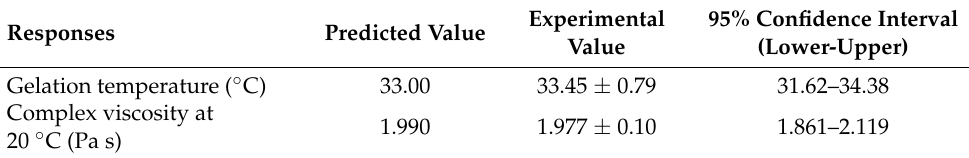
Table 2. The predicted and observed responses of the optimized thermosensitive hydrogel.